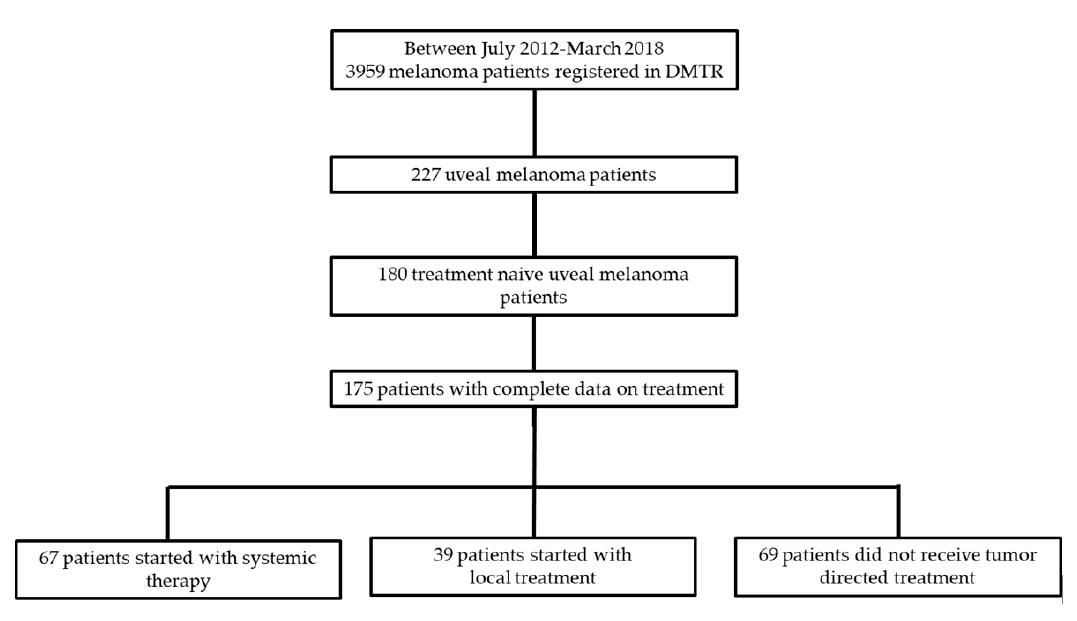
Figure 1. Nation-wide cohort of metastatic uveal melanoma patients registered in the Dutch Melanoma Treatment Registry (DMTR): All patients with complete data on treatment were analyzed and subdivided based on the first treatment option when diagnosed with metastatic disease. The median age of metastatic UM patients in this cohort was 65 years. The majority of patients (74.9%) scored well on the World Health Organization (WHO) performance scale (0–1). Lactate dehydrogenase level (LDH) was elevated in 85 (48.6%) patients (Table 1). The liver was the most affected site: 88% of patients having liver metastases. Other affected sites were the lungs (25.1%),